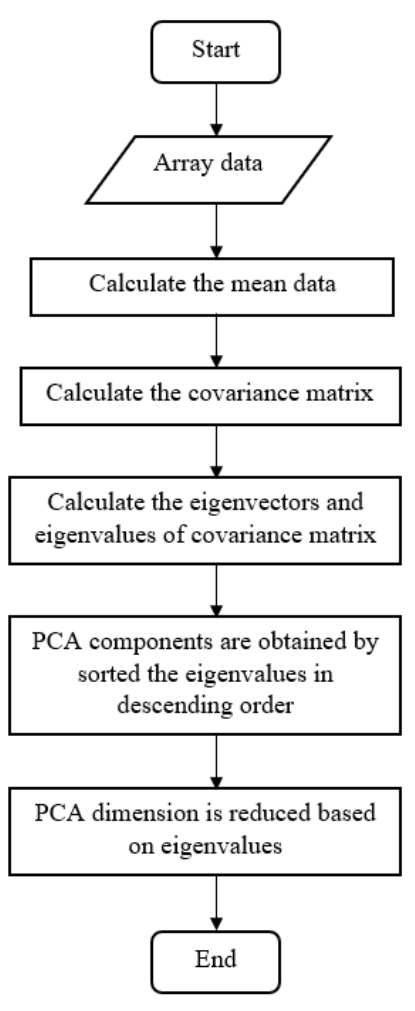
Figure 3. Process of dimensionality reduction using PCA. The eigenvalue decomposition based on mean data maximizes the covariance matrix. Then, in the column and row-wise direction, two-directional projection matrices in the x-